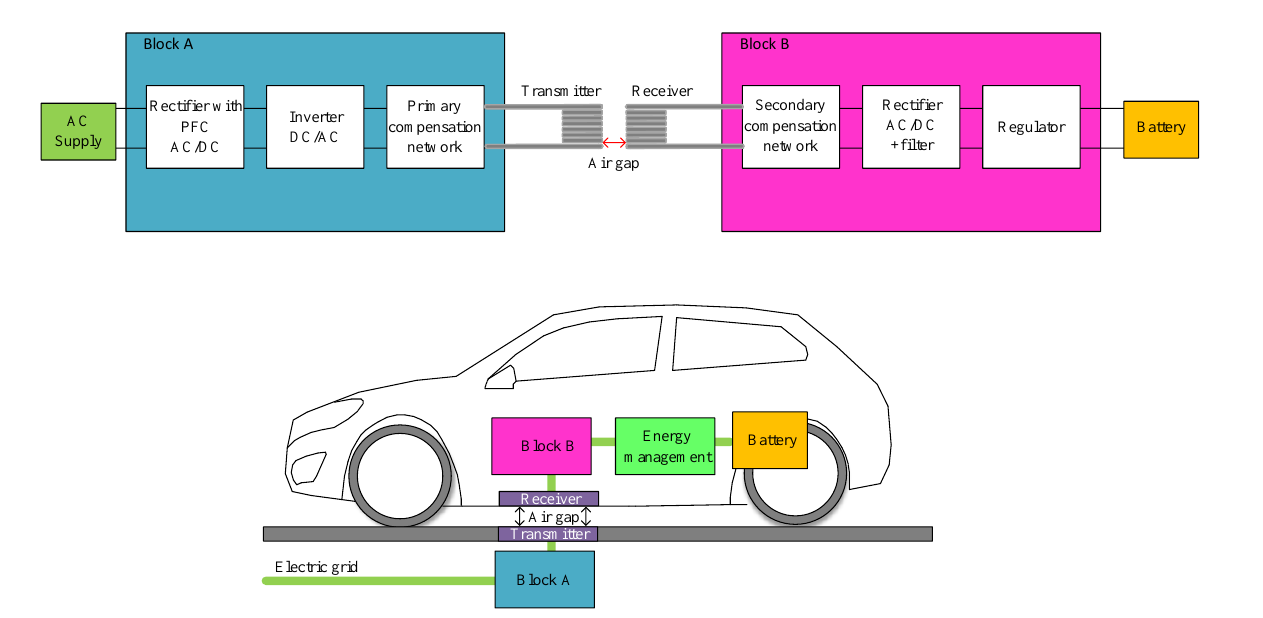
Figure 15. Wireless charging system designed for electric vehicles.